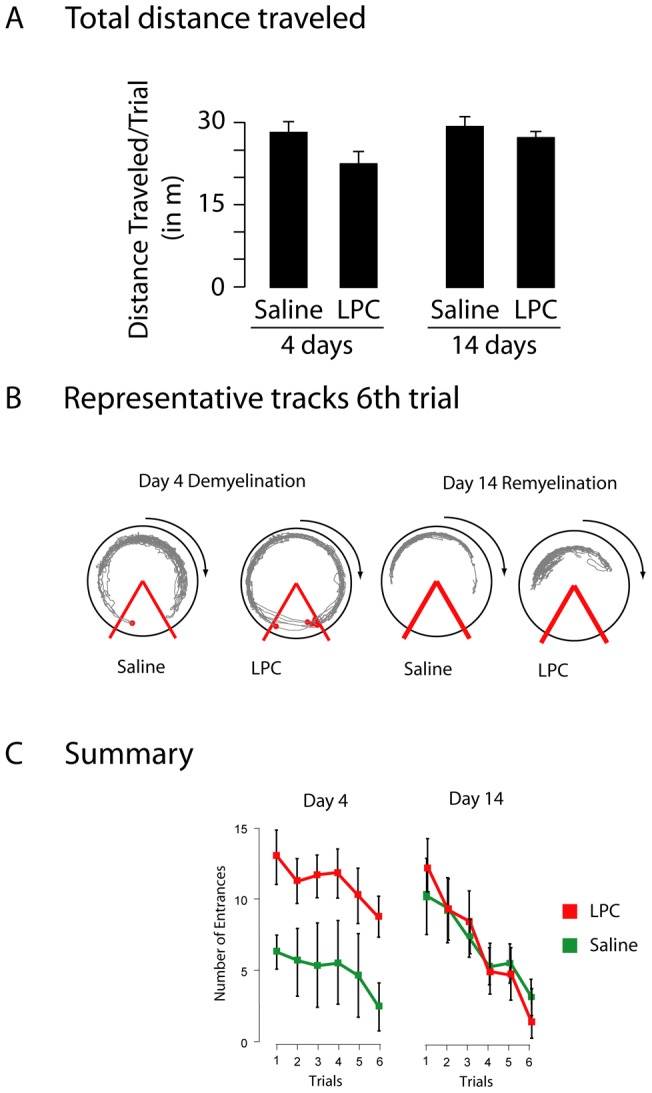
Behavioral analyses at times of demyelination and remyelination.
Panel A, Total distance traveled during active place avoidance. Rats injected with LPC or saline traveled a similar distance at both 4 and 14 days (F(3,19)  = 1.71). Panel B, Representative tracks of rats 4 or 14 days after saline or LPC injection on the final (6th) trial of active place avoidance. Red lines indicate the shock zone boundaries and the red circles indicate the locations where shocks were delivered. Panel C, Summary of the number of shock zone entrances in each trial of active place avoidance. At 4 days, saline- and LPC-injected animals showed a significant effect of treatment (F(1,10)  = 16.31, p<0.005) and trial (F(5,50)  = 4.20, p<0.005) with no interaction of treatment and trial (F(5,50)  = 0.47). At 14 days, saline and LPC-injected animals had an no significant effect of treatment (F(1,10)  = 0.23), but there was a significant effect of trial (F(5,55)  = 5.81, p<0.001). Saline-treated animals analyzed at 4 and 14 days showed no significant effect of days (F(1,12)  = 1.78), but there was a significant effect of trial (F(5,60)  = 3.35, p<0.0005). LPC-injected rats at 4 and 14 days, trended toward an effect of days (F(1,9)  = 4.0, p = 0.08) but had a significant effect of trial (F(5,45)  = 10.4 p<0.0001) and a significant interaction of treatment and trial (F(5,45)  =  2.62, p<0.05). These data suggest that saline-injected animals acquired the active place avoidance task at both 4 and 14 days, whereas LPC-injected animals acquired the task only at 14 days. Saline- and LPC-injected animals differed in their acquisition the task at 4, but not 14 days.